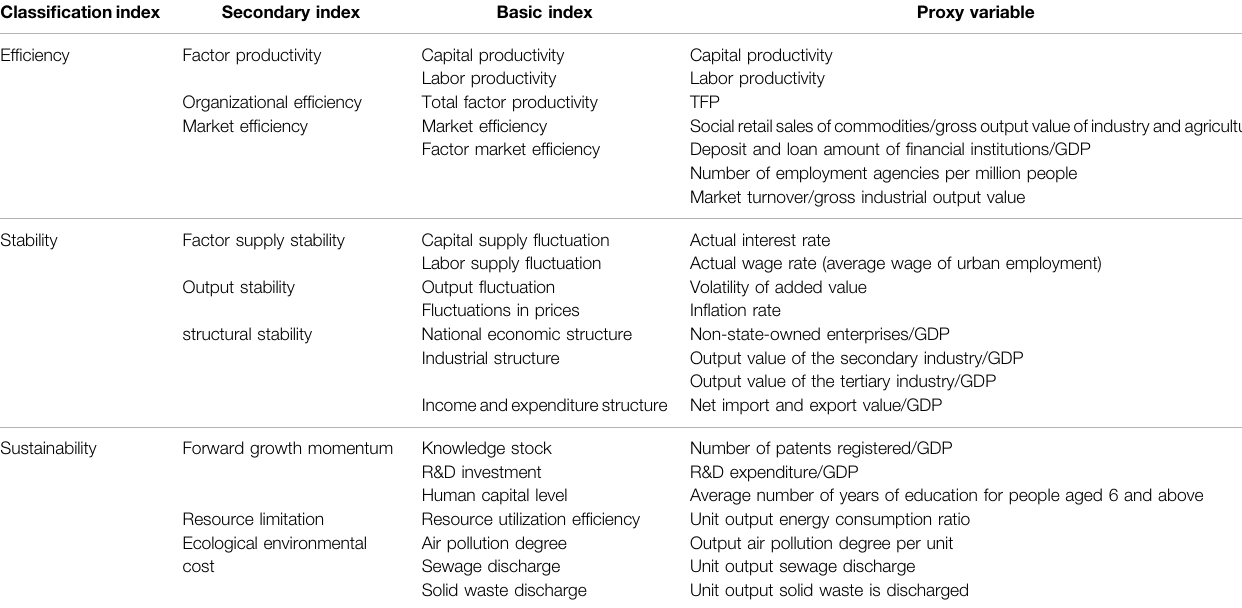
TABLE 1 | Comprehensive evaluation index system of economic growth quality.